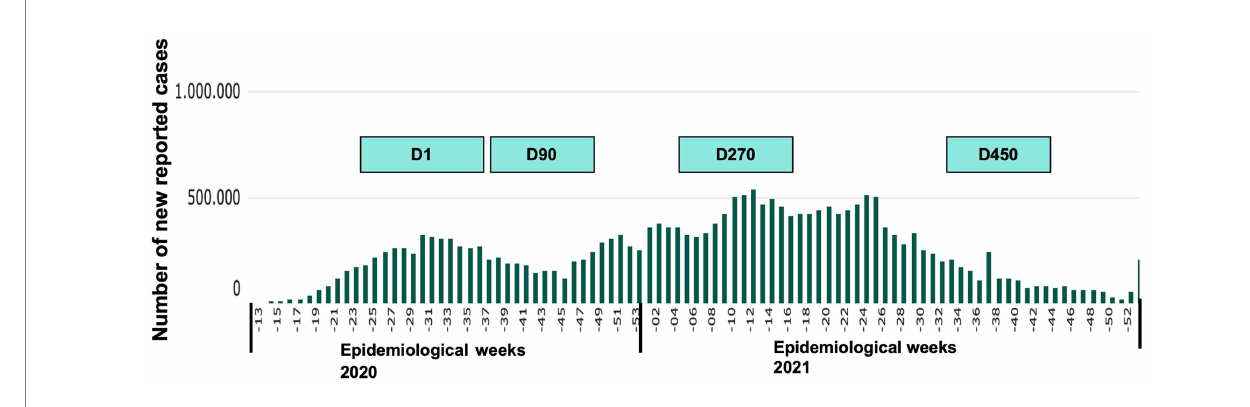
FIGURE 1 Data collection at different points in time, considering the number of new COVID-19 cases (adapted from CONASS - National Council of Health Secretaries https://www.conass.org.br/painelconasscovid19/).